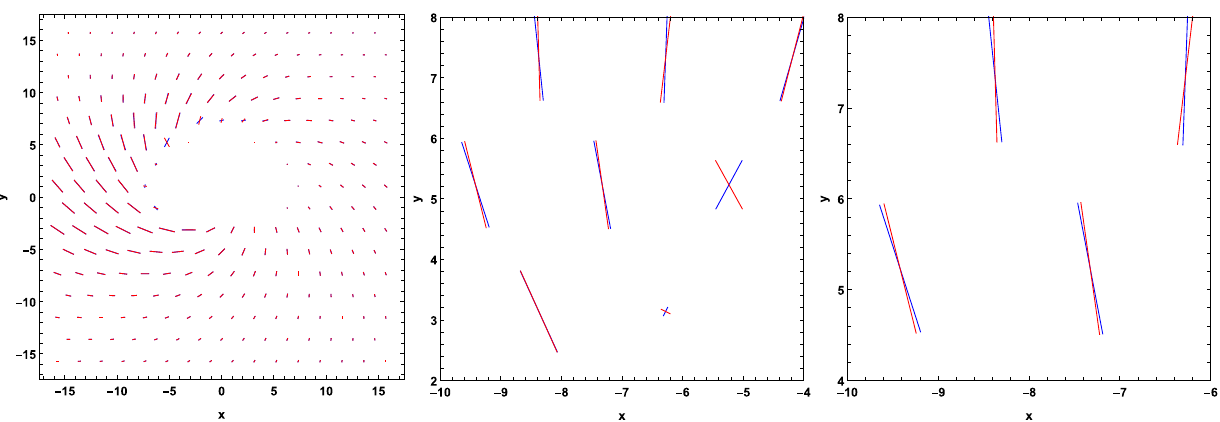
Fig. 11 Difference of the total observed polarization in the cases α = − 0 . 4 and α = 0 . 4 for θ o = 70 ◦ . The red line and the blue line correspond to α = − 0 . 4 and 0 . 4, respectively. The panel on the right is an enlargement of that in the left. Here, we set M =